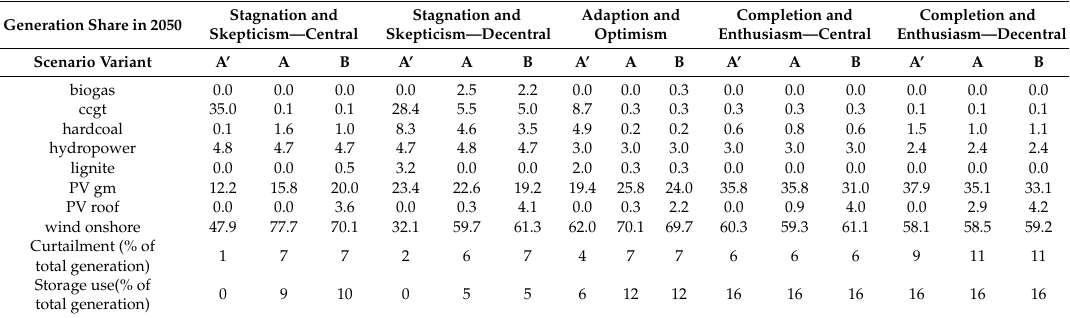
Table 4. Shares of electricity generation per technology in 2050 in percent for the A’, A, and B variant. GenerationSharein2050 Stagnation and Skepticism—Central Adaption and Optimism Completion and Enthusiasm—Central Completion and